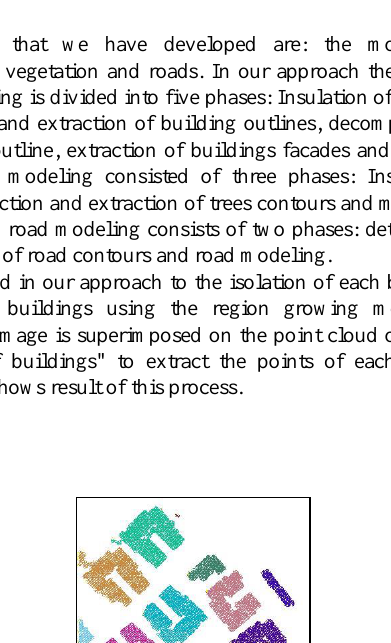
Figure 4: Automatic detecting the roof of buildings and roads and soil class.